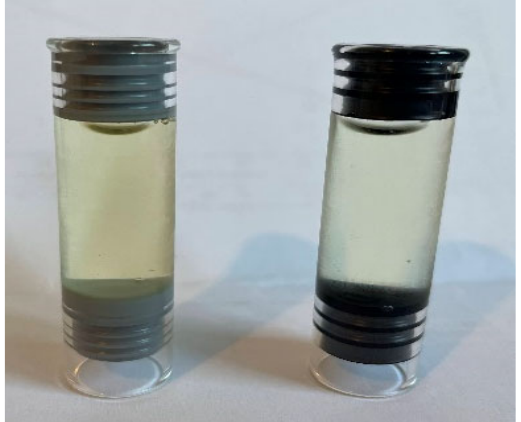
Figure 1. Example of the two sealing elastomeric gasket pieces (black colour right one and grey colour left part of the figure) located in the glass syringes.